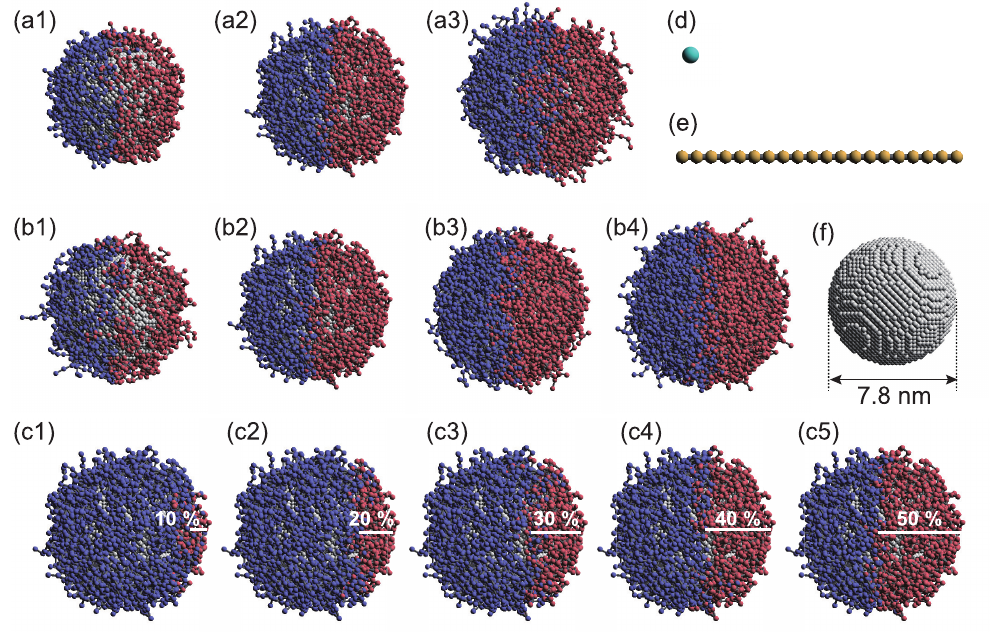
Figure 1. Simulation models. Variations in the ( a1 – a3 ) tethered polymer length L (( a1 ) three, ( a2 ) six, and ( a3 ) nine beads); ( b1 – b4 ) graft density ρ (( b1 ) 0.8, ( b2 ) 1.5, ( b3 ) 3.0, and ( b4 ) 6.0); and ( c1 – c5 ) coverage ratio φ (( c1 ) 10%, ( c2 ) 20%, ( c3 ) 30%, ( c4 ) 40 %, and ( c5 ) 50%) of polymer-tethered